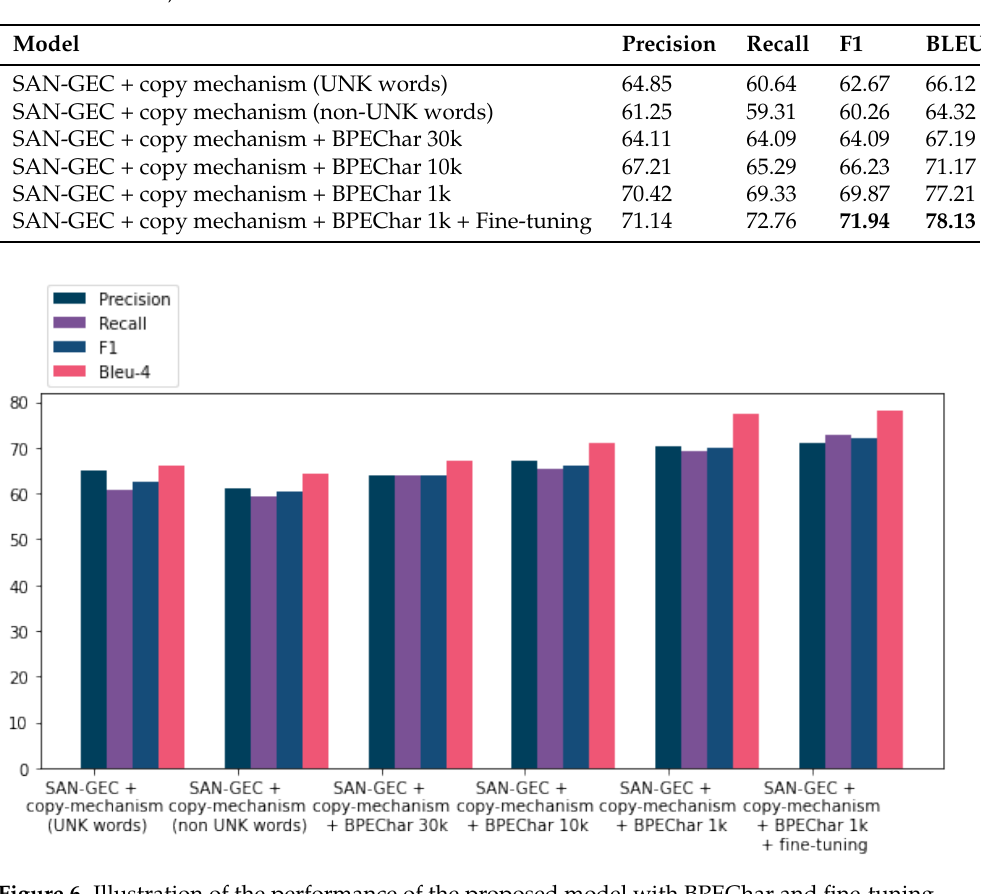
Figure 6. Illustration of the performance of the proposed model with BPEChar and